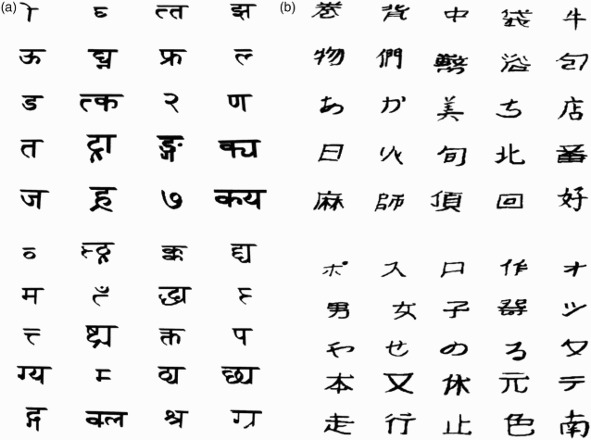
Examples of Hindi and Japanese characters used for the order
reconstruction and recognition tasks.